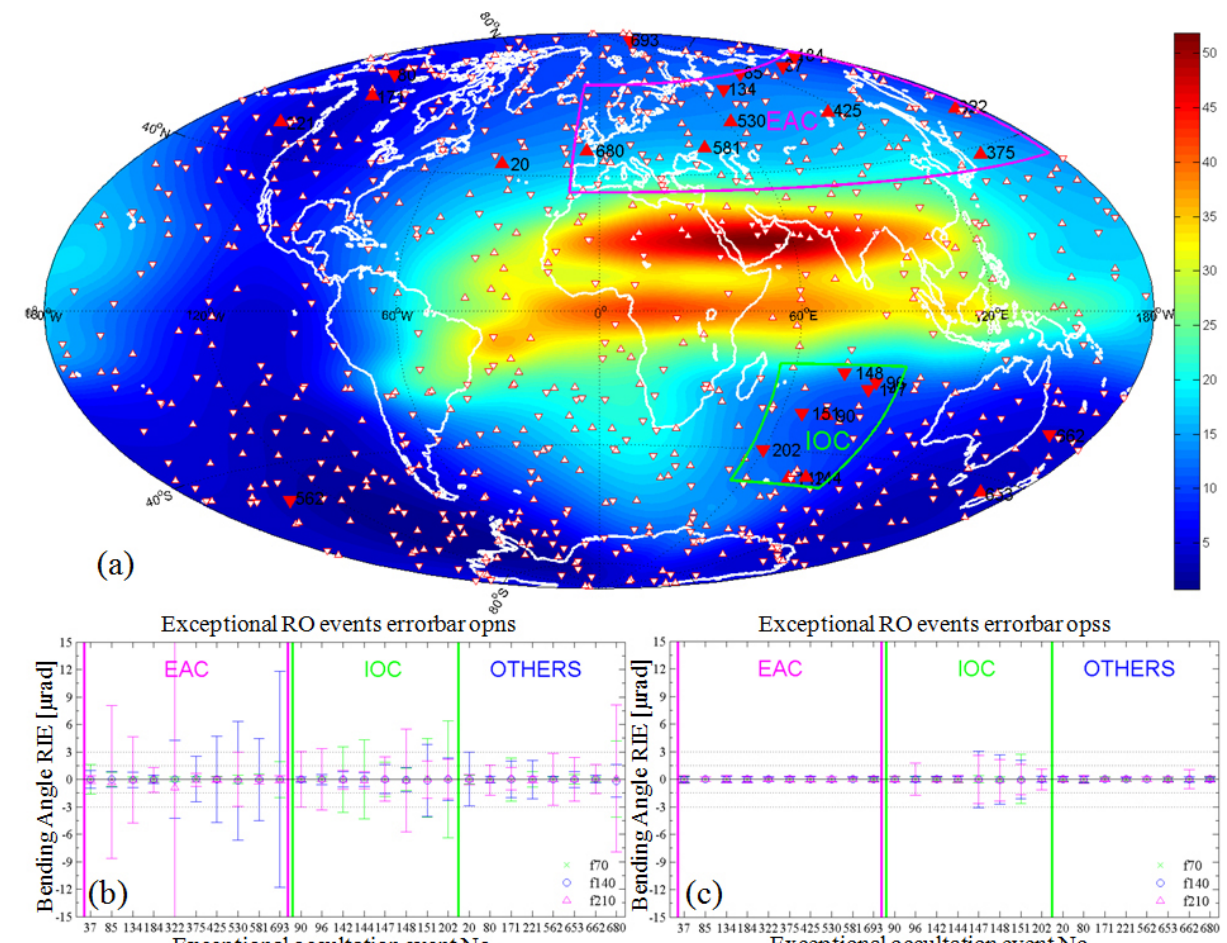
Figure 2. Distribution of the mean tangent point locations of the 723 RO events simulated by Liu et al. (2015) for 15 July 2008 (a) , including 697 events with standard RIE (small-white triangles) and 26 events with exceptional RIE (red triangles; upward-pointing, rising events; downward-pointing, setting events). The latter 26 events mainly reside in the European–Asian cluster (EAC; magenta box) and Indian Ocean cluster (IOC; green box). The background color map illustrates the vertically integrated total electron content (vTEC) of the NeUoG ionospheric model for medium solar activity (for 12:00UTC of 15 July; F10.7 = 140; shown in TEC units, 1 TECU = 10 16 electronsm − 2 ) . The bottom panels depict the RIEs for a perfect observing system (op) with no observational errors and non-spherical (opns) (b) as well as spherically symmetric (opss) (c) ionospheric conditions. They show the bending angle RIE bias (symbols) and standard deviation (error bars) estimates for the 30–80km range for low (F10.7 = 70, green), medium (F10.7 = 140, blue), and high (F10.7 = 210, red) solar activity, for each of the 26 exceptional events (ordered by clusters, with those not falling into EAC and IOC marked as OTHERS), with each one identified by its chronological RO event number of the